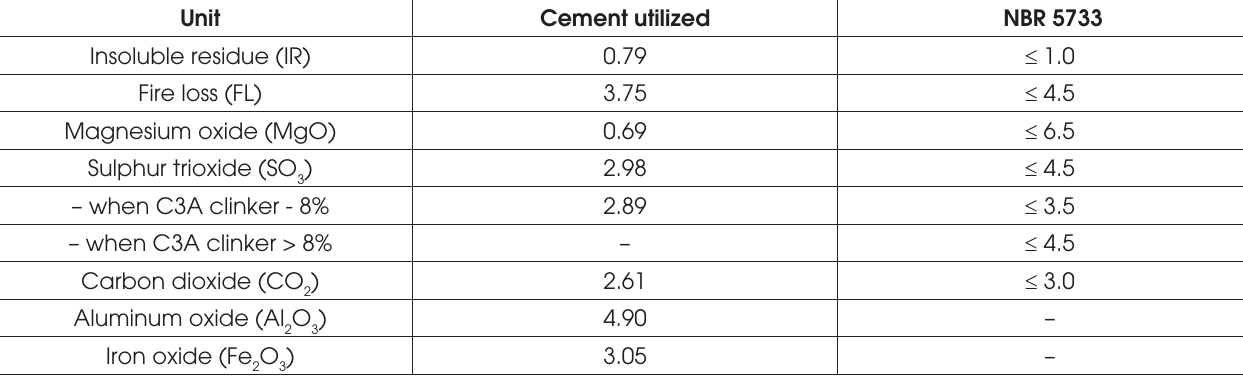
Chemical properties of the cement CPV